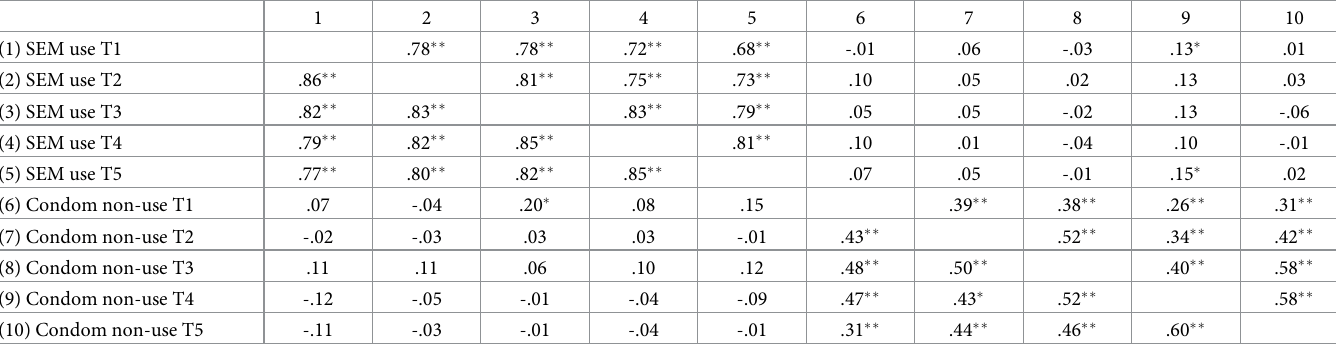
Table 3. Cross-correlations between SEM use and unprotected sexual intercourse by wave and panel sample.